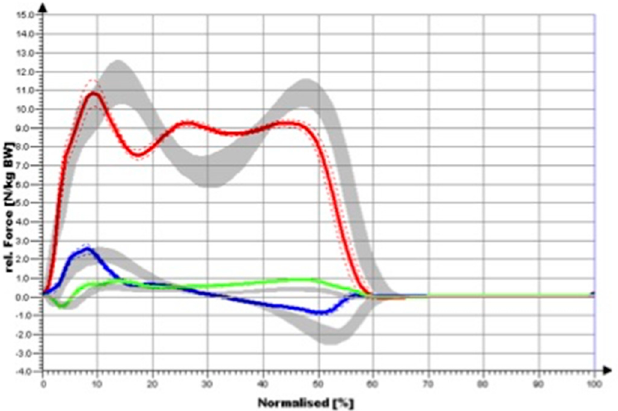
Figure 2. Three–dimensional vector representation of ground reaction forces during walking (OS): red; (CS): blue; (NP): grey.